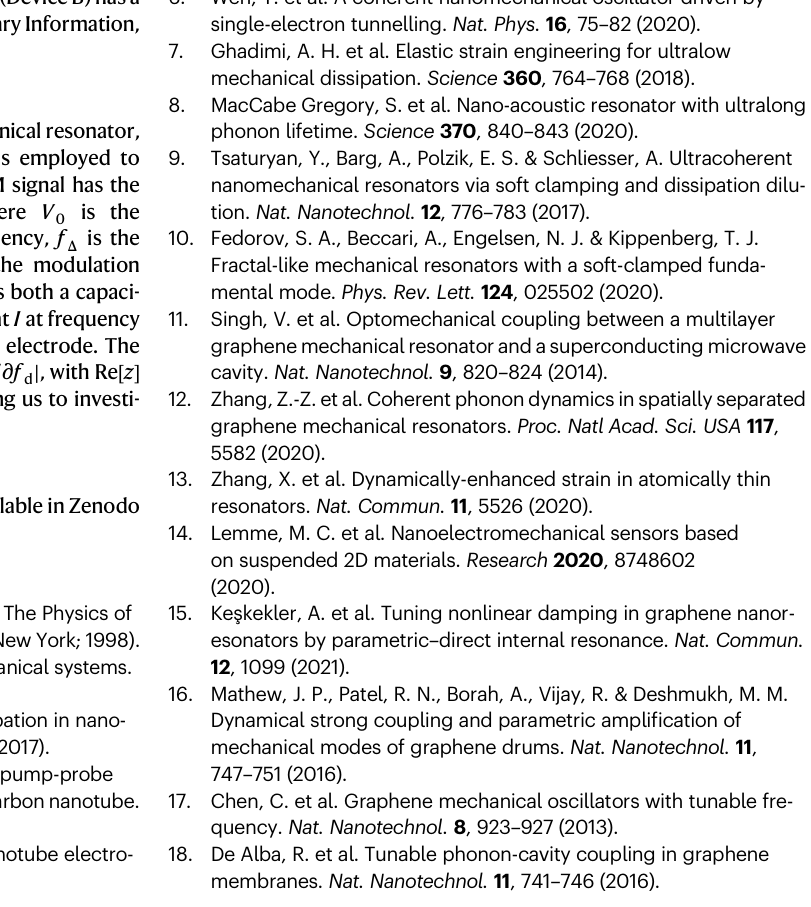
state (2)), strain within R L and R R increases. The concomitant in-plane sliding and out-of-planedisplacementof R L and R R giverisetoatensionwithintheresonators, R which acts asa restoringforce (state (2) tostate (3)). c Schematic plot showing the M . sliding distance, the out-of-plane displacement and the tension within the reso- nators upon increasing and decreasing V G